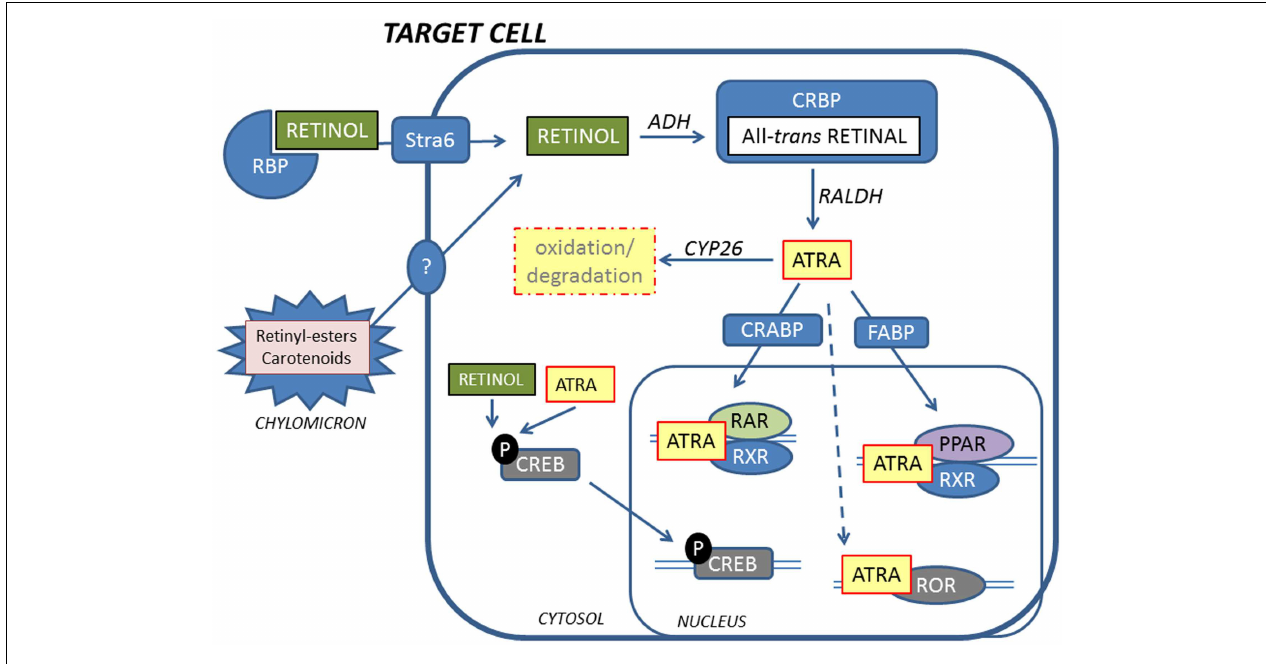
respectively. RARs and PPARs form heterodimers with RXRs to activate transcription. In addition, ATRA can bind to RORs to initiate transcription. Non-genomic effects of retinoids include phosphorylation of CREB that translocates to the nucleus and activates genes. ATRA is inactivated by oxidation by CYP26